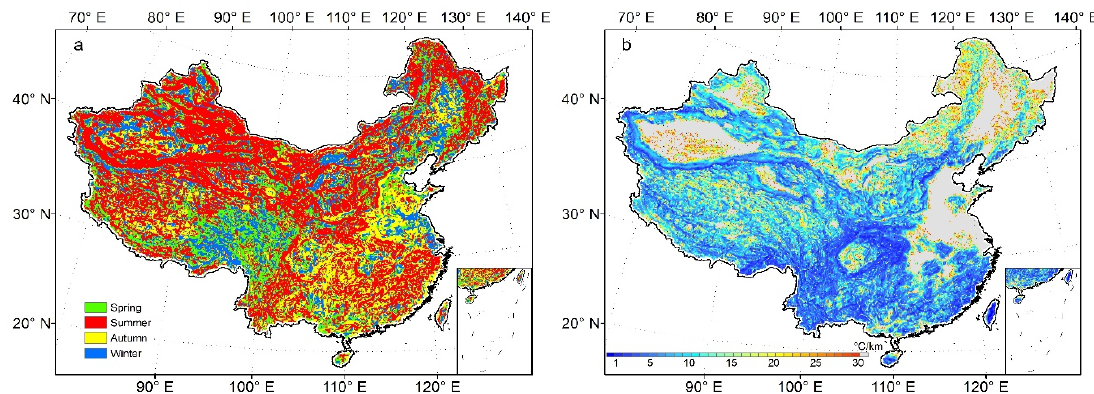
Figure 11. Seasonal pattern ( a ) and magnitude of variability ( b ) of the TLR. The type of seasonal pattern in patch ( a ) indicates in which season the steepest TLR took place. The magnitude of variability in patch ( b ) represents how much the TLR changed within a year. The grey color indicates the patches where the confidence of the calculating results was low due to the flat topography.